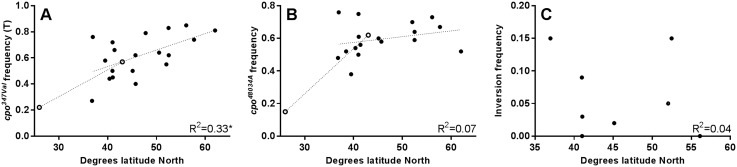
European frequencies of cpo polymorphisms and In(3R)Payne.Frequency of cpo347Val in European populations plotted against latitude. Open circles, southern- and northern-most American populations [5], filled circles, European populations. * p<0.05. B) Frequency of cpo48034A in European populations against latitude. C) Frequency of In(3R)Payne against latitude.